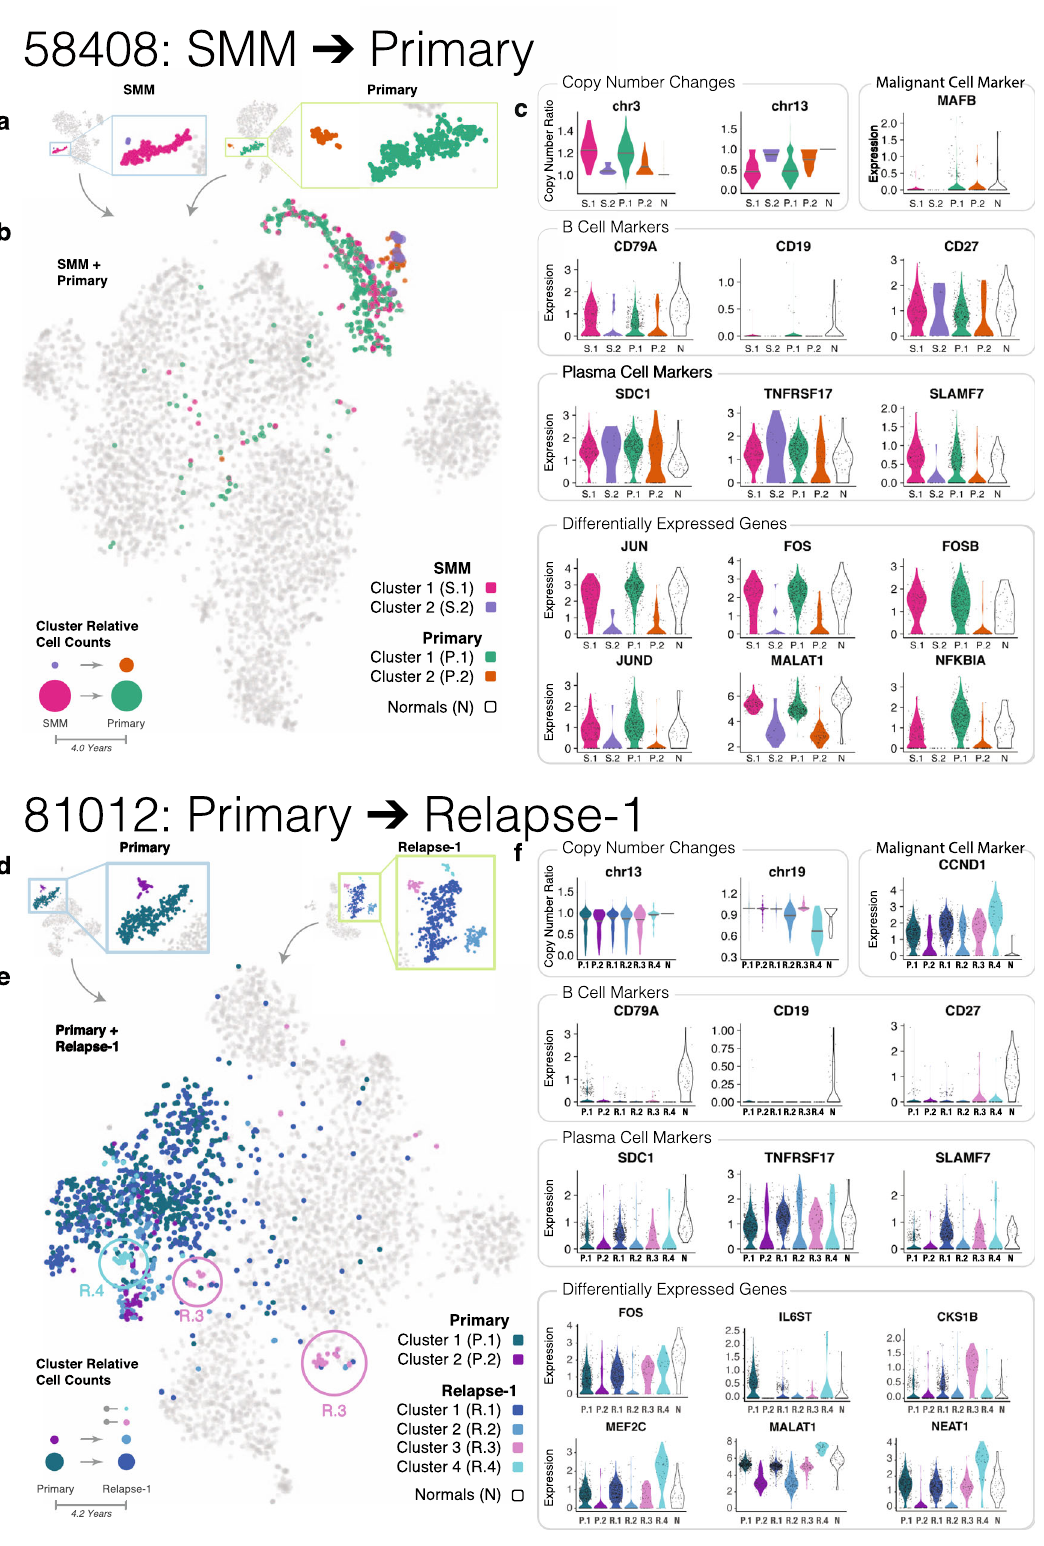
Fig. 4 Patterns of plasma cell subpopulation shift from SMM to Primary (58408) and from Primary to Relapse (81012). a Plasma cell t-SNE subclusters for Patient 58408 at SMM and Primary time points. b Plasma cell subclusters identi fi ed in a mapped to the integrated t-SNE of all cells from Patient 58048 SMM and Primary time points. Bottom left: possible explanation for plasma cell subpopulation shift from SMM to Primary. c Copy number and expression patterns for plasma cells from different time point subclusters and plasma cells from healthy donors. The fi rst row shows copy number changes and expression of genes associated with genetic alterations detected in Patient 58408. The second and third rows show the expression of B cell markers and plasma cell markers. The last two rows show differentially expressed genes found between the clusters. d – f Similar illustrations as a – c except for Patient 81012, who progressed from Primary to